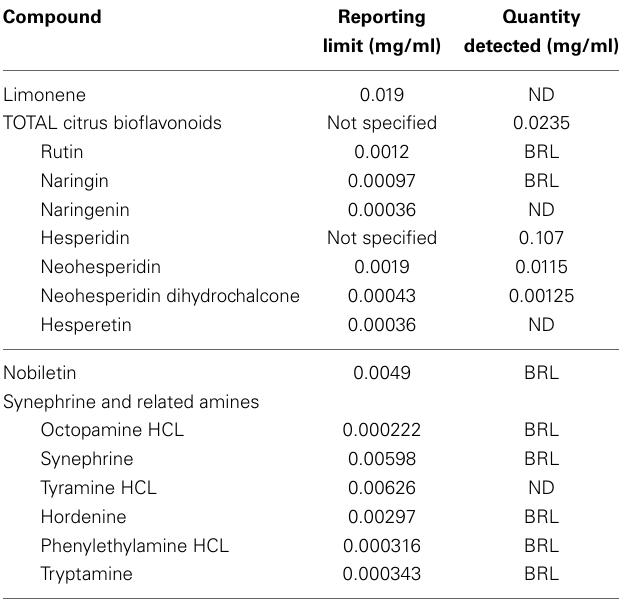
FIGURE 1 | Dose dependent effect of C. aurantium extract on seizure latency to PTZ in adult zebrafish. Animals were allowed absorption on various concentrations of C. aurantium extracts before exposure to PTZ 3mg/ml. C. aurantium extracts at 14, 20, 28, 35, and 56mg/ml, significantly increased seizure latency compared to naïve animals. The dotted line represents seizure latency of naïve animals. Results are shown as average ± SEM of at least three experiments, n > 9. ∗ vs. naïve P < 0 . 05; ∗∗ P < 0 . 01; ∗∗∗∗ P < 0 .